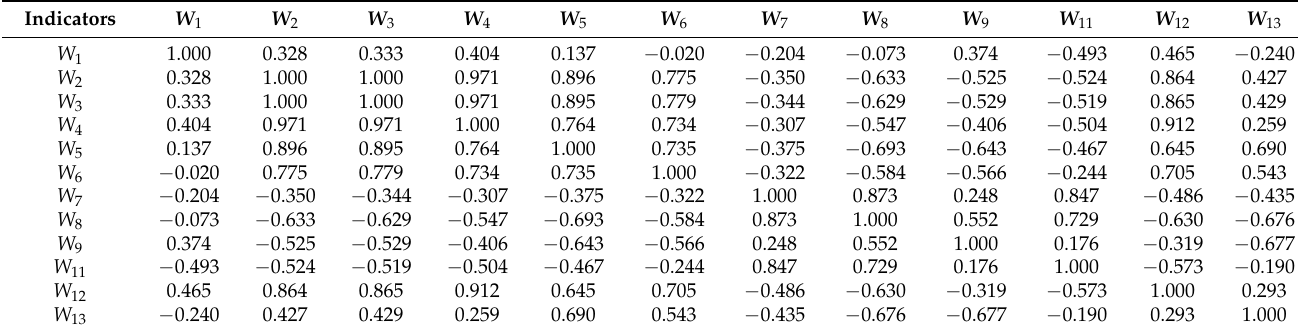
Table 1. Pearson’s correlation coefficients between indices for